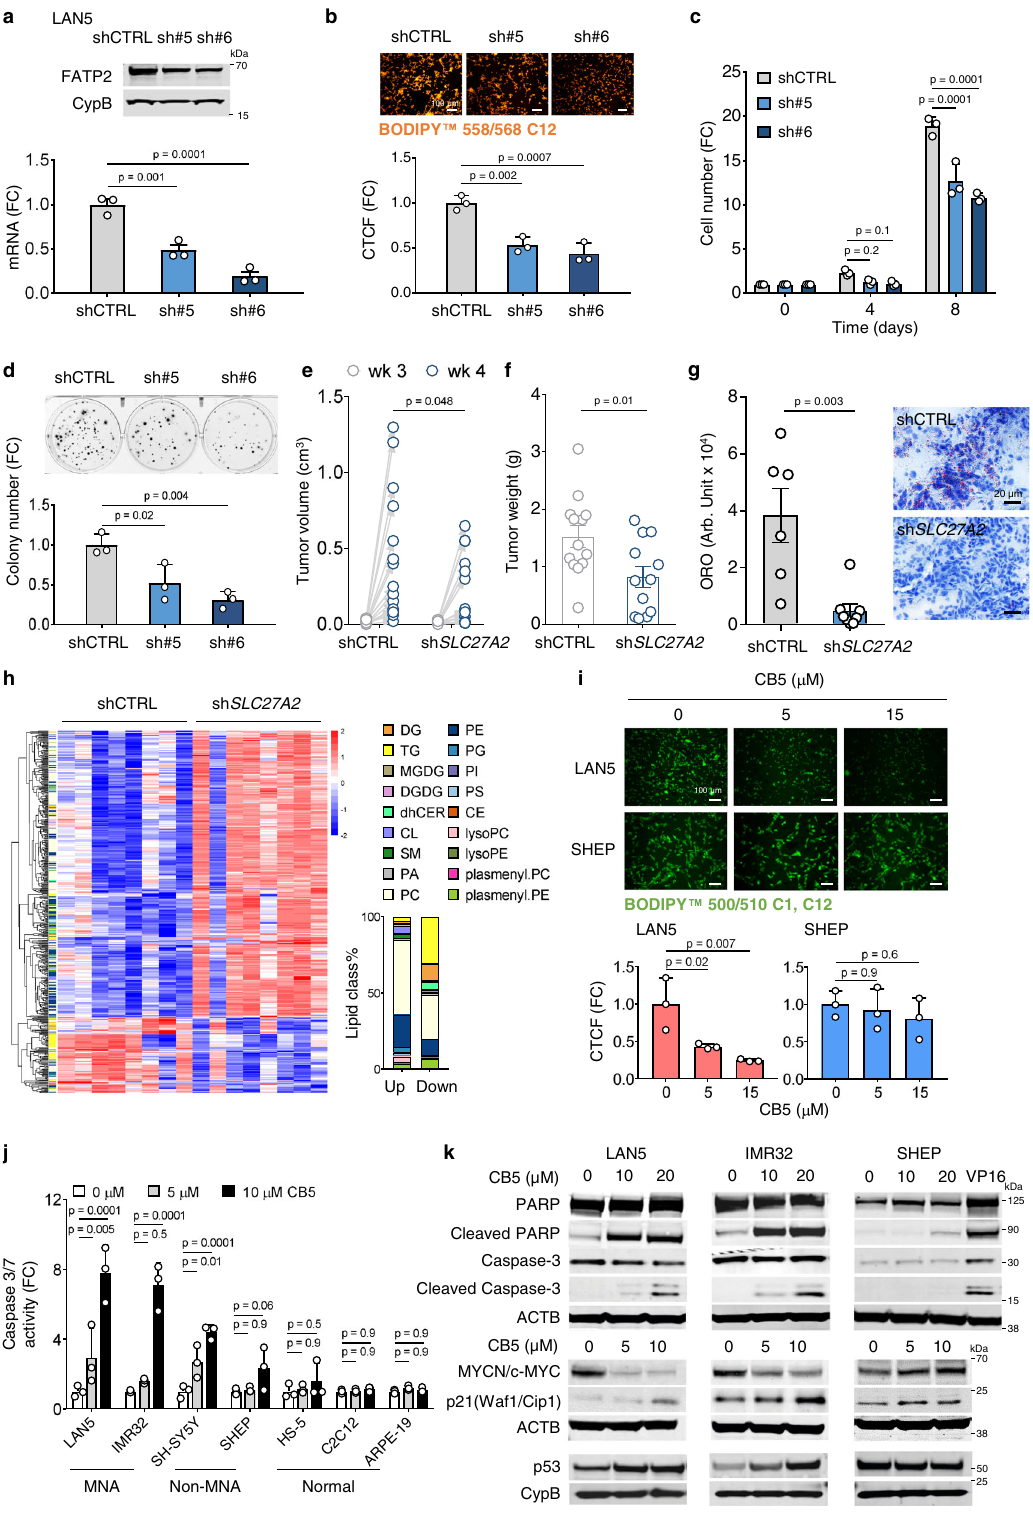
(Fig. 6c). Combination therapy (CB5: 15 mg/kg, b.i.d ., i.p . 6 days/ week and VP16: 8 mg/kg, i.p . 3 days/week) markedly reduced fi nal tumor weights compared with monotherapies ( p < 0.0005, Fig. 6c). Moreover, CB5 + VP16 demonstrated enhanced effects on tumor cell proliferation and apoptosis ( p ≤ 0.05,